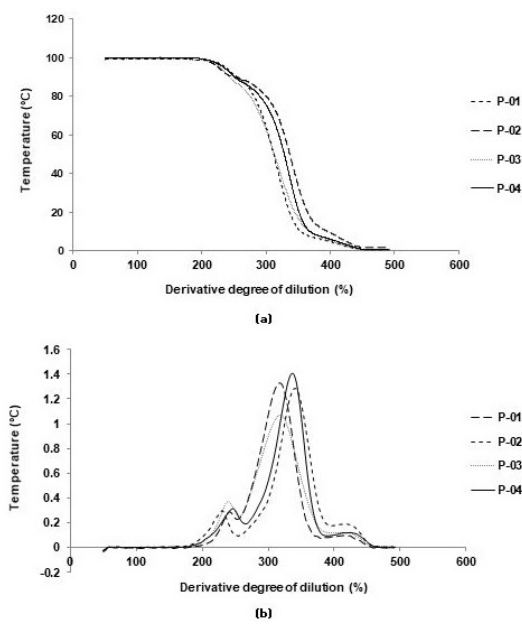
Figure 6. TGA (a) and DTG (b) curves of the copolymers P-01, P-02, P-03, P-04 and P-05.